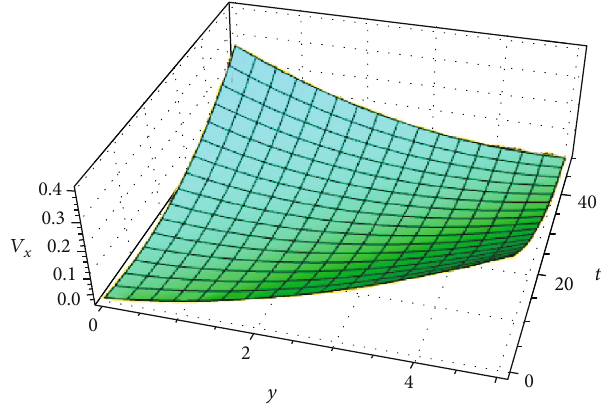
Figure 2: Spatiotemporal velocity pro fi le V